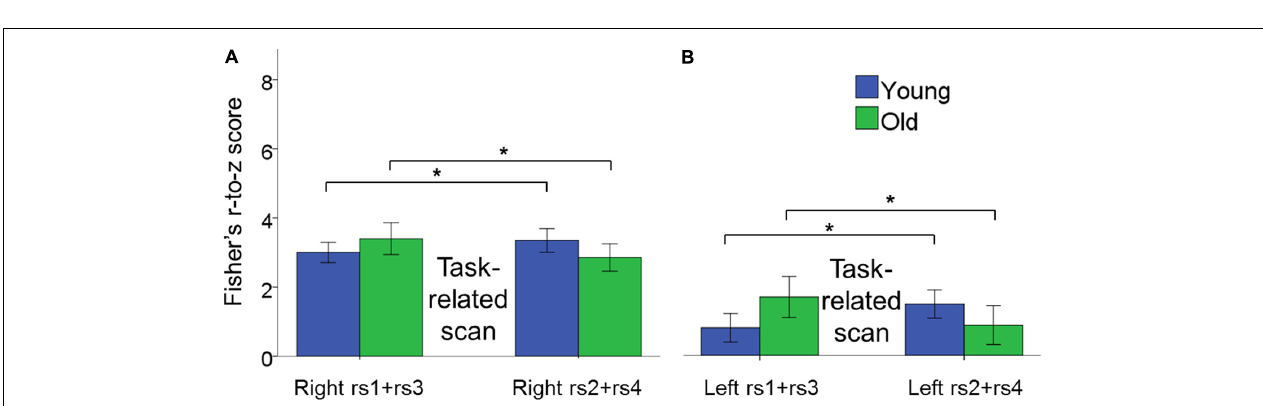
FIGURE 7 | Bar plots show the age × scan location interaction effect for intra-hemispheric functional connectivity. (A) Changes in connectivity in right hemisphere pairs of regions. (B) Changes in connectivity in left hemisphere pairs of regions. In both cases, functional connectivity increased after task performance in YA, whereas it decreased after task performance in OA within pre- and post-test sessions. Error bars represent